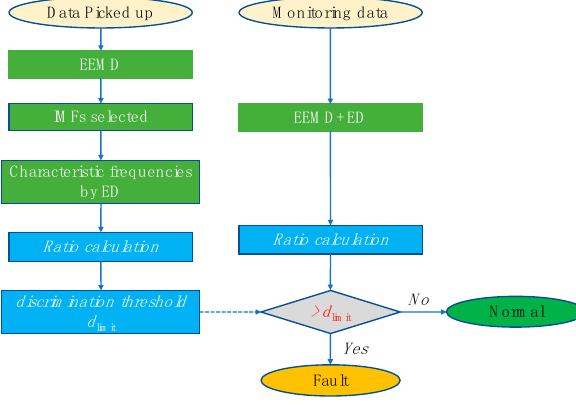
Figure 8. The automatic bearing fault diagnosis process.